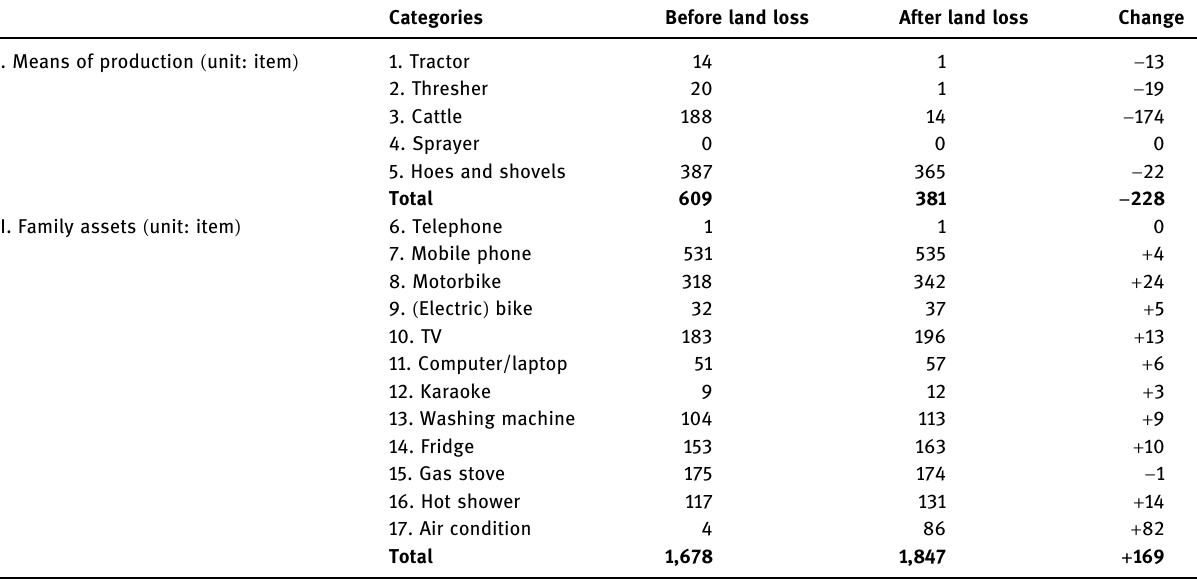
Table 5: Property of households